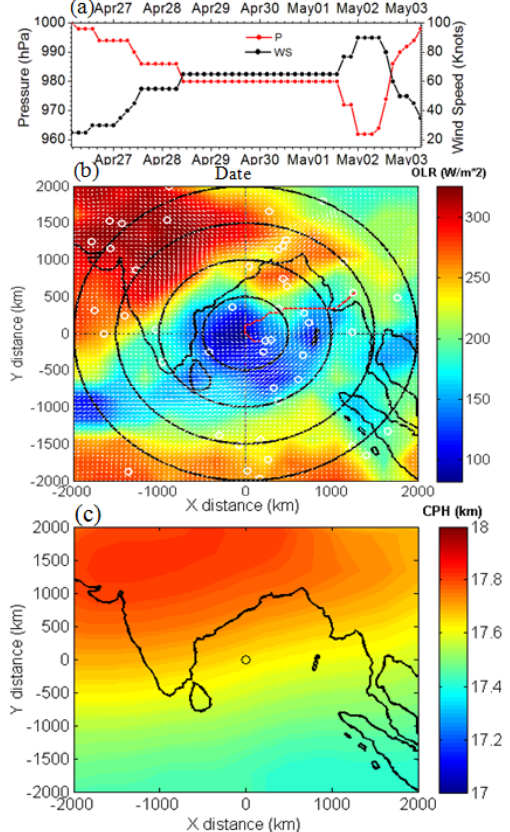
Figure 2. (a) IMD-observed minimum sea level pressure (MSLP; red line) and maximum wind speed (black line) during TC Nargis. (b) TC-centred composite of NOAA OLR observed on 28 April 2008 along with IMD-observed Nargis track (red line). White arrows show the wind vectors obtained from ERA-Interim on the same day. White circles show the COSMIC RO observed on the same day. Black circles are drawn to shown the 500, 1000, 1500, and 2000km distance away from TC centres. (c) Climatol- ogy of CPH for the month of April obtained while averaging from 2002 to 2013. The small black circle shows the Nargis TC centre observed on 28 April 2008.